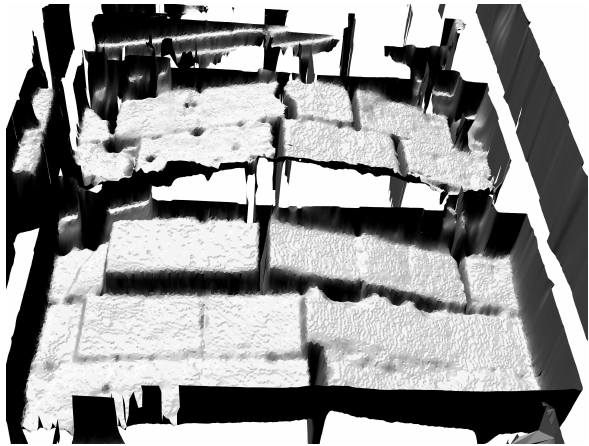
Figure 1: Analysis of the deformation of a wall, Baalbek, Lebanon. Horizontal deformations are magnified 10 times. In- teractive analysis of a data set, trying to understand and model the